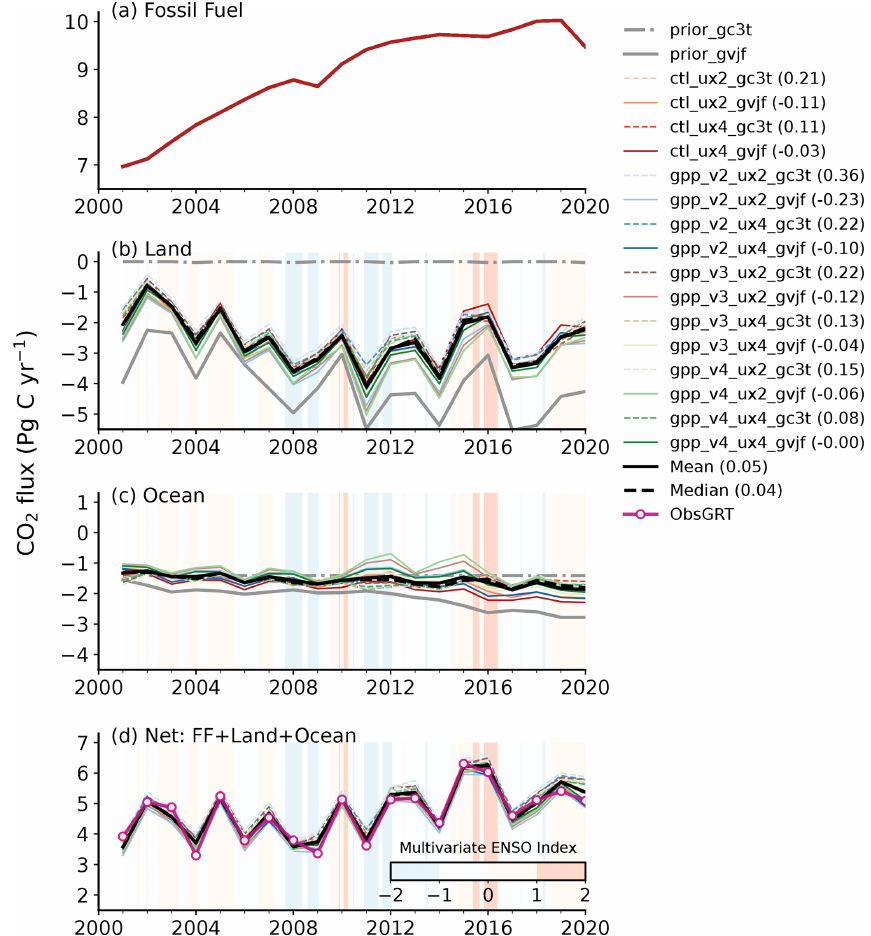
Figure 5. Global annual CO 2 emissions from fossil fuel (a) and estimated land (b) and ocean (c) carbon sink from two sets of prior and 16 sets of predicted fluxes based on different combinations of priors (gc3t and gvjf), prior flux uncertainties (PFU: ctl, gpp_v2, gpp_v3, gpp_v4) and measurement data uncertainties (MDU: ux2, ux4). Negative values show uptake by land/ocean, and positive values show sources to the atmosphere. The net flux is calculated by subtracting the total sink (land + ocean) from the fossil fuel and compared with the observed global growth rate of atmospheric CO 2 concentration from the NOAA/ESRL (magenta line in panel (d) ; Dlugokencky and Tans, 2020). The atmospheric CO 2 growth rate is converted using a factor of 2.13PgCppm − 1 . The numbers in the brackets in the legend are the mean budget imbalance between annual means of net flux and observed CO 2 growth rate (units:PgCyr − 1 ). The background shading (positive/brown for El Niño and negative/blue for La Niña) shows the multivariate El Niño–Southern Oscillation (ENSO) index or MEI (Wolter and Timlin,